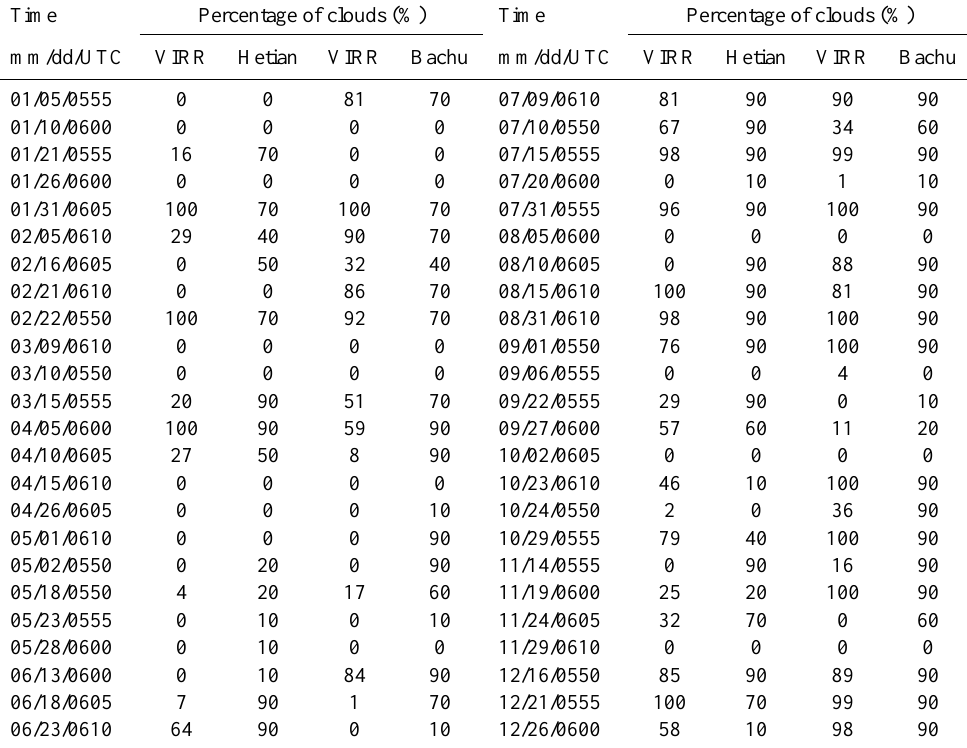
Table 7. Comparisons between ground-based observations and the VIRR cloud mask results of the proposed algorithm. Time